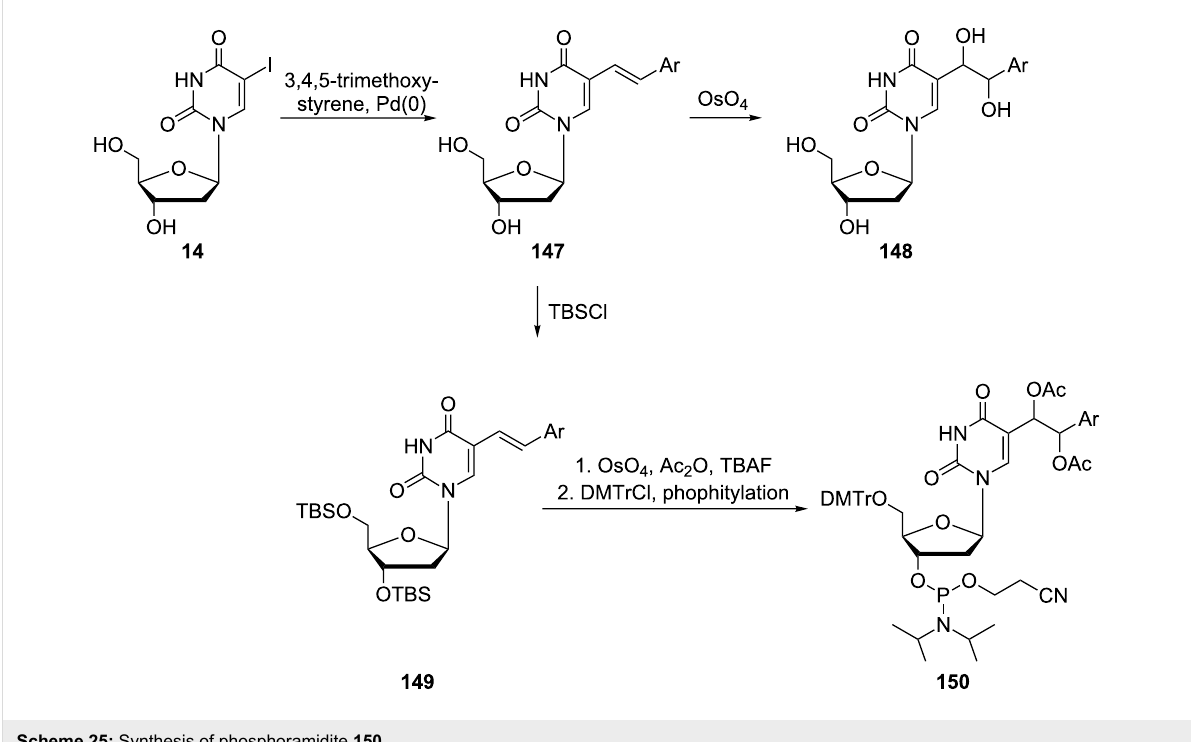
Scheme 25: Synthesis of phosphoramidite 150 .